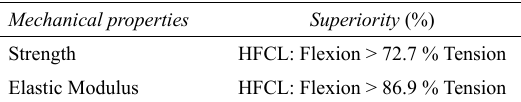
Table 5. Influence of hybridization method on laminate HFCL specimens.